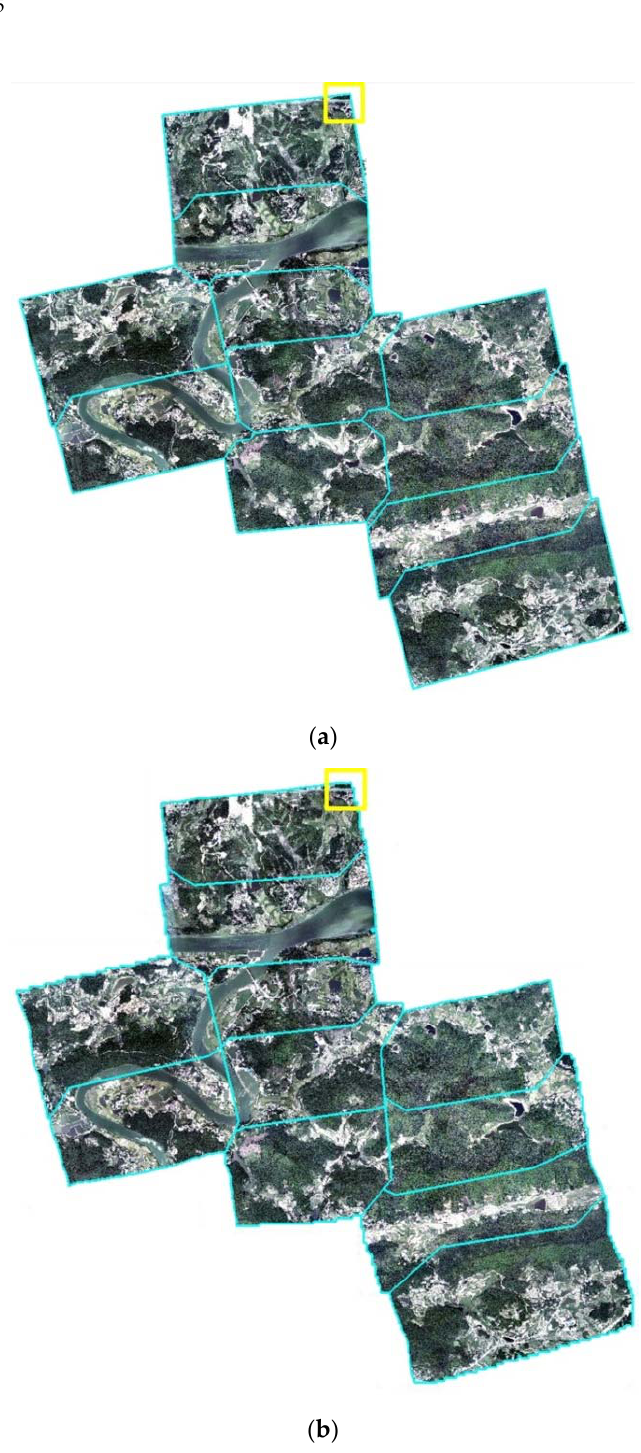
Figure 10. Results: ( a ) the generated seamline network overlapping the mosaic of Data Set 1 by Pan et al.’s (2014) method; ( b ) the generated seamline network overlapping the mosaic of Data Set 1 by Wan et al.’s (2013) method.